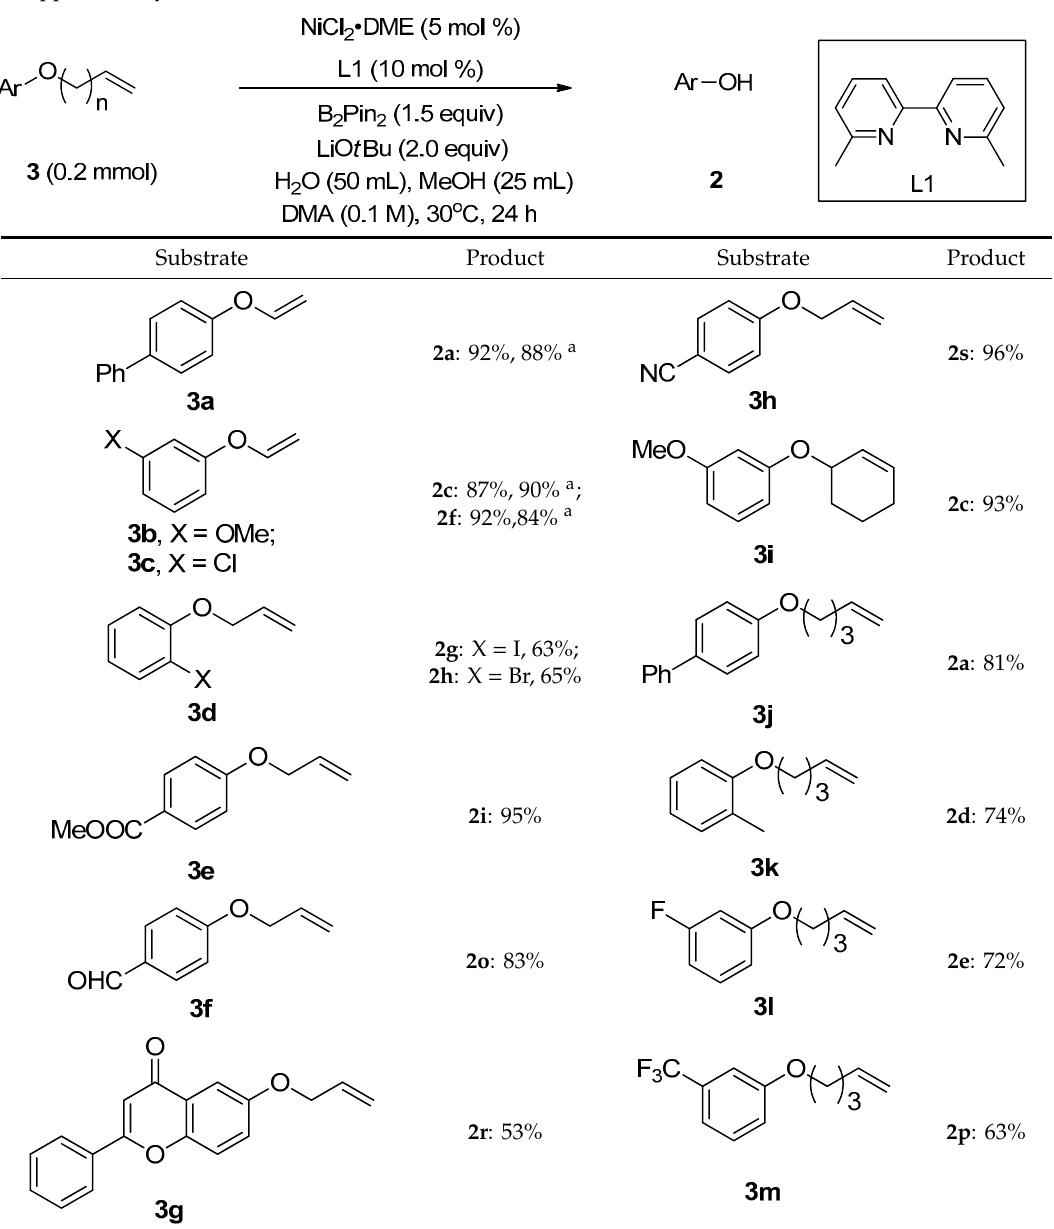
Table 3. Scope of alkene protecting groups. Conditions: a Without Ni catalyst and ligand. See Supplementary Materials for details.